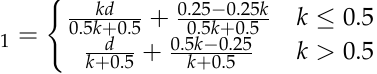
u o _ d 1 Figure 10. The optimized control of soft ‐ switching and no backflow power.